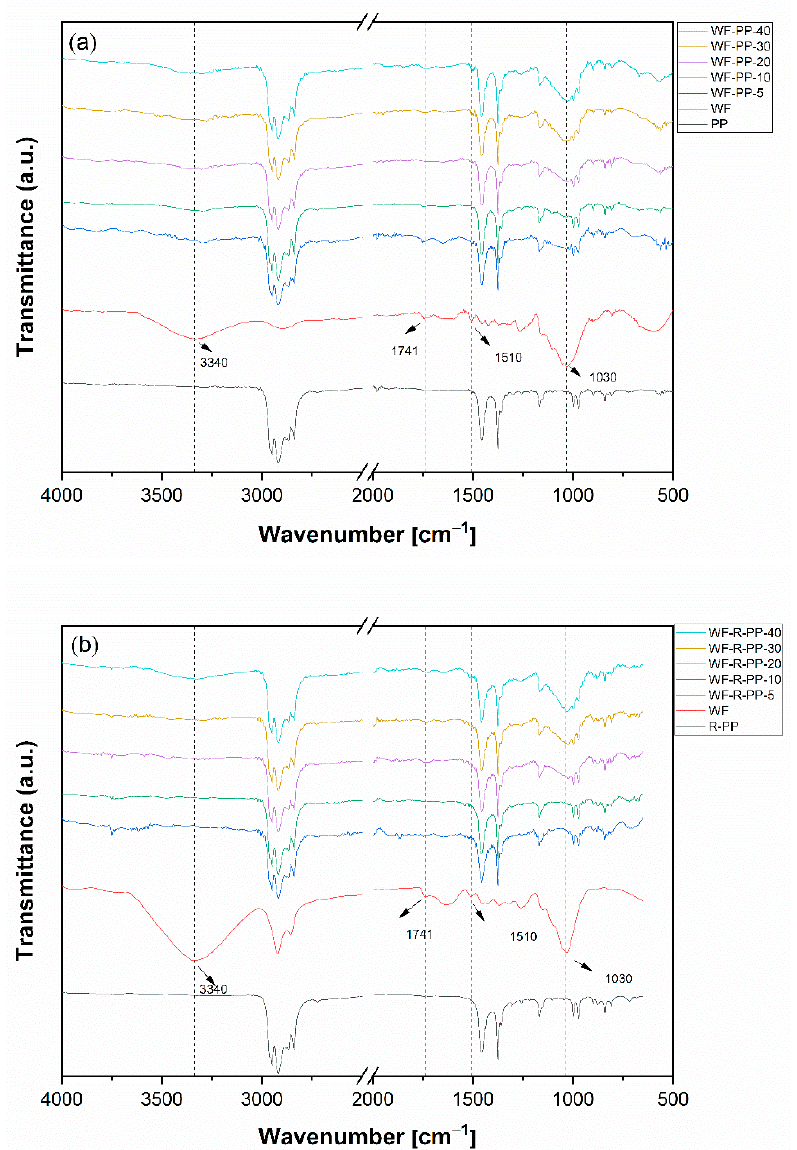
Figure 4. ATR-FTIR spectra of ( a ) unrecycled PP, WF, WF-PP composites and ( b ) recycled PP (R-PP), Figure 4. ATR ‐ FTIR spectra of ( a ) unrecycled PP, WF, WF ‐ PP composites and ( b ) recycled PP (R ‐ PP), WF, WF-R-PP composites with di ff erent concentration of WF, WF ‐ R ‐ PP composites with different concentration of WF.